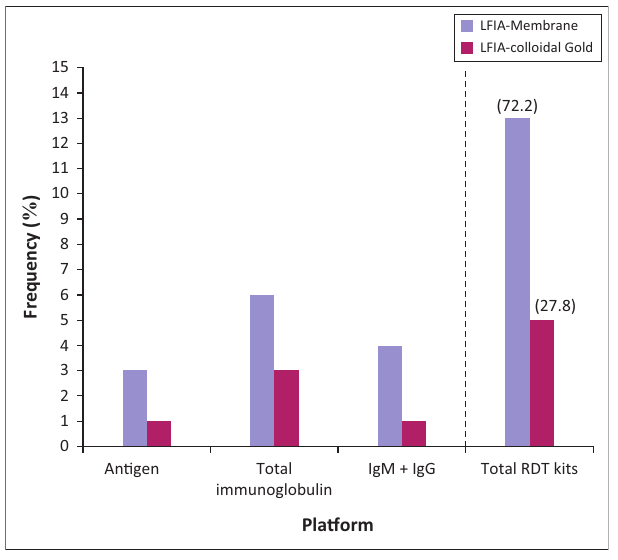
FIGURE 4: Distribution of the serological rapid diagnostic tests by testing platform.